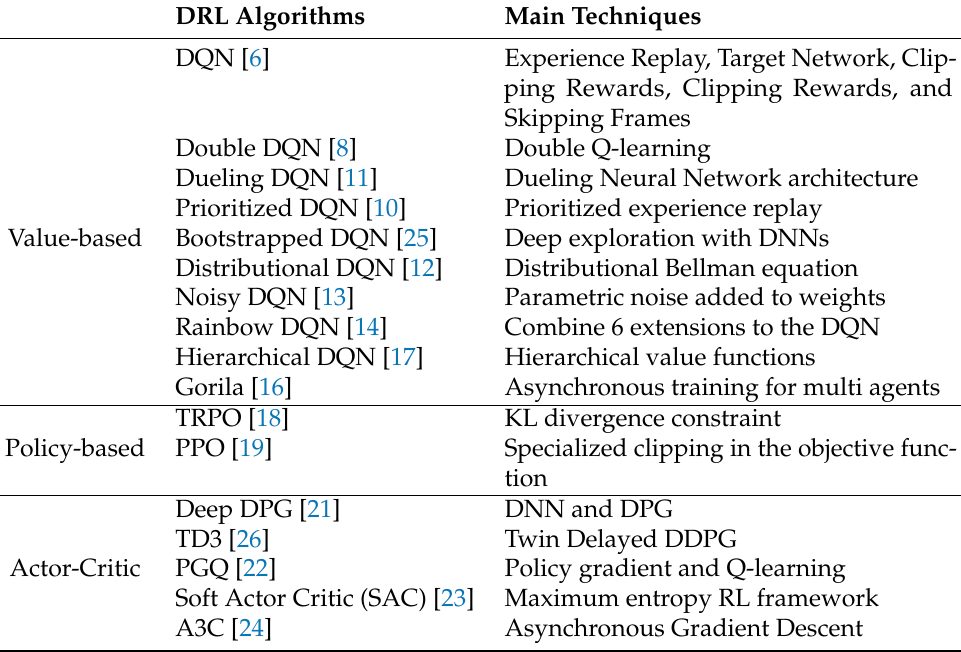
Table 1. Representative DRL